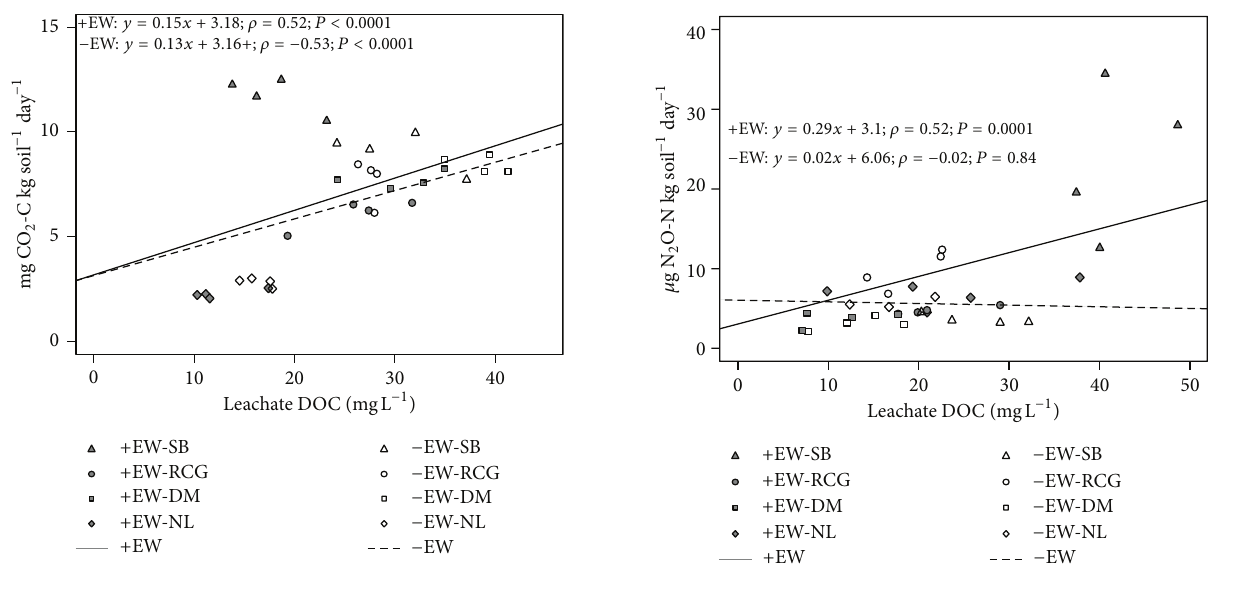
Figure 4: Scatter plot showing the functional relationship between N 2 O flux and NO 3 concentration in leachate. Each point is the mean of 9 measurements taken of 1 of the 4 replicates during a 20 wks incubation study from microcosms filled with riparian soil that had earthworms present (EW, 𝑛 = 36 ) or no earthworms (NW, 𝑛 = 36 ) and received no litter (NL), soybean (SB), reed canarygrass (RCG), ordeciduous-mixlitter(DM)asthelittersource.Thelinearequation and standard error of the estimated slope of the line describe the functional relationship for EW and NW treatments, across litter types. The strength of the relationship is given as Spearman’s rank correlation coefficient ( 𝜌 ) and significance of each relationship ( P